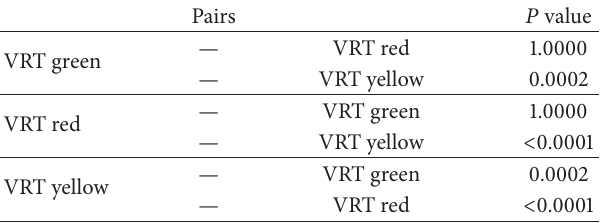
Table 1: Age and anthropometric measurements of the subjects. Parameters